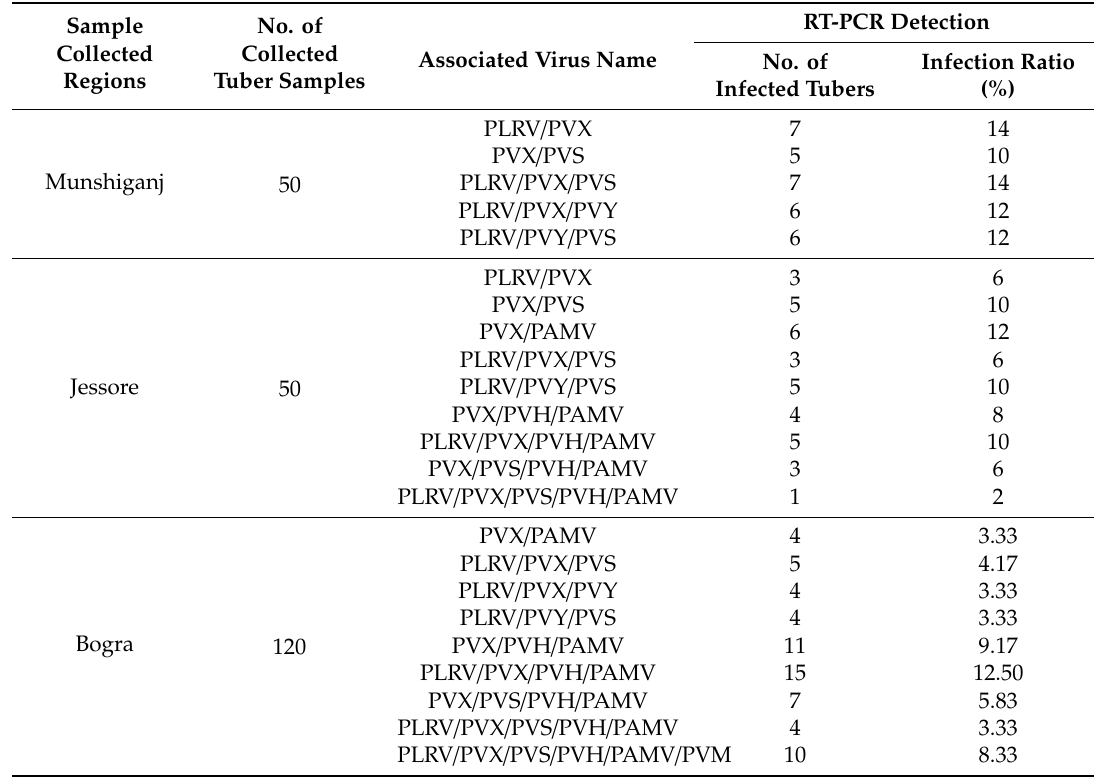
Table 1. Incidence of potato viruses in 220 tuber samples collected from three major potato growing regions (Munshiganj, Jessore and Bogra districts) of Bangladesh in 2017–2018.